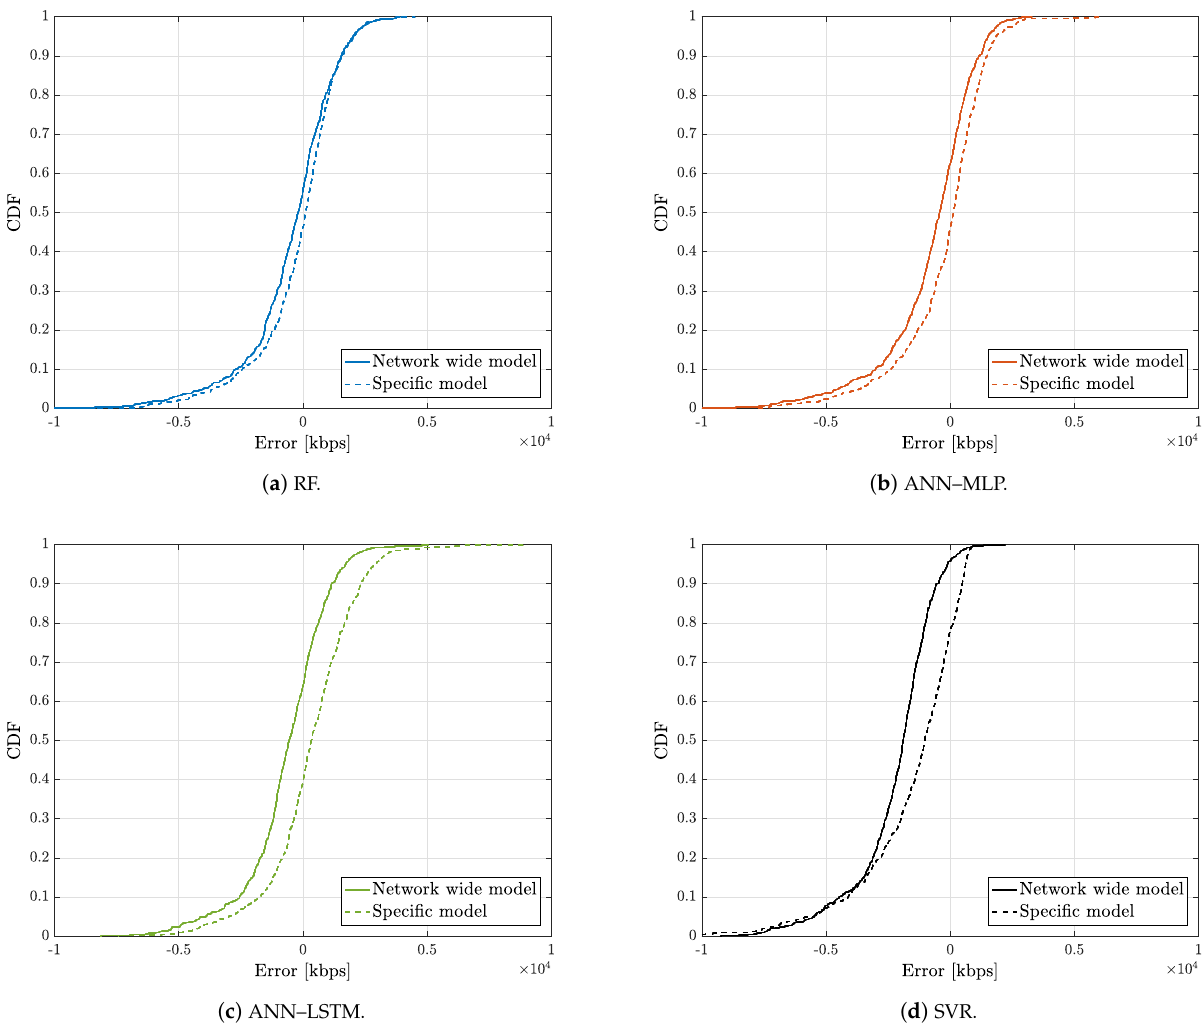
Figure 7. Error cumulative distribution functions for SL methods in high-traffic cells (case